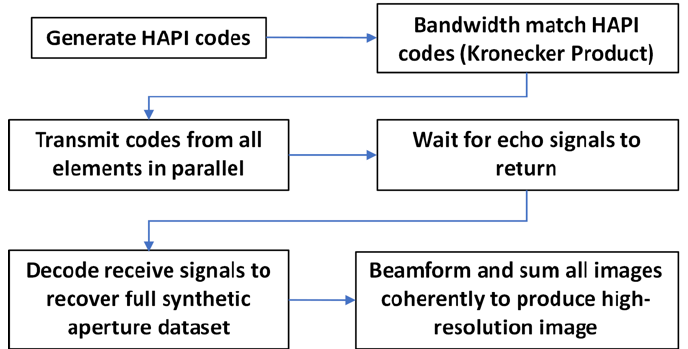
Figure 3. Flow diagram of imaging with HAPI codes. First, 128 HAPI codes are generated. Then they are bandwidth-matched to improve correlation properties. The codes are then transmitted in parallel from all elements and echo signals are received. Decoding is then performed on the echo signals using cross-correlation to recover the full synthetic aperture dataset. Beamforming and summing are then performed on the full recovered dataset to form a high-resolution image.